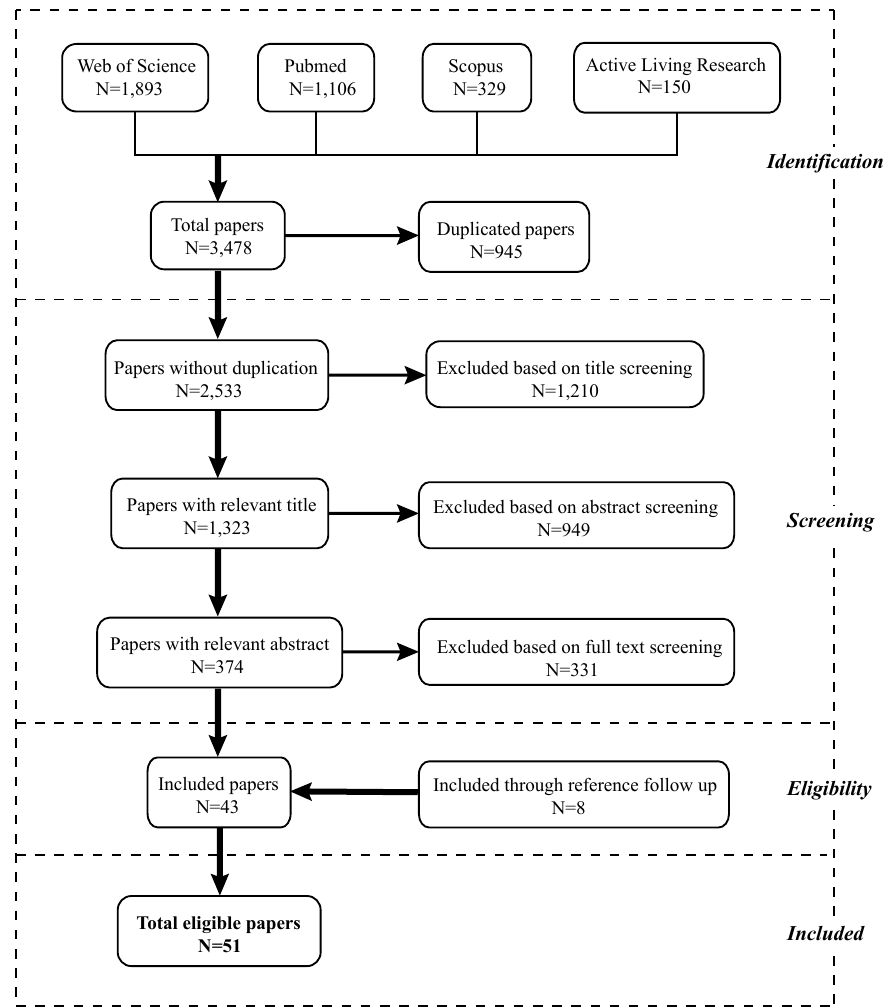
Figure 1. Flow of literature search process (based on the PRISMA flow diagram).